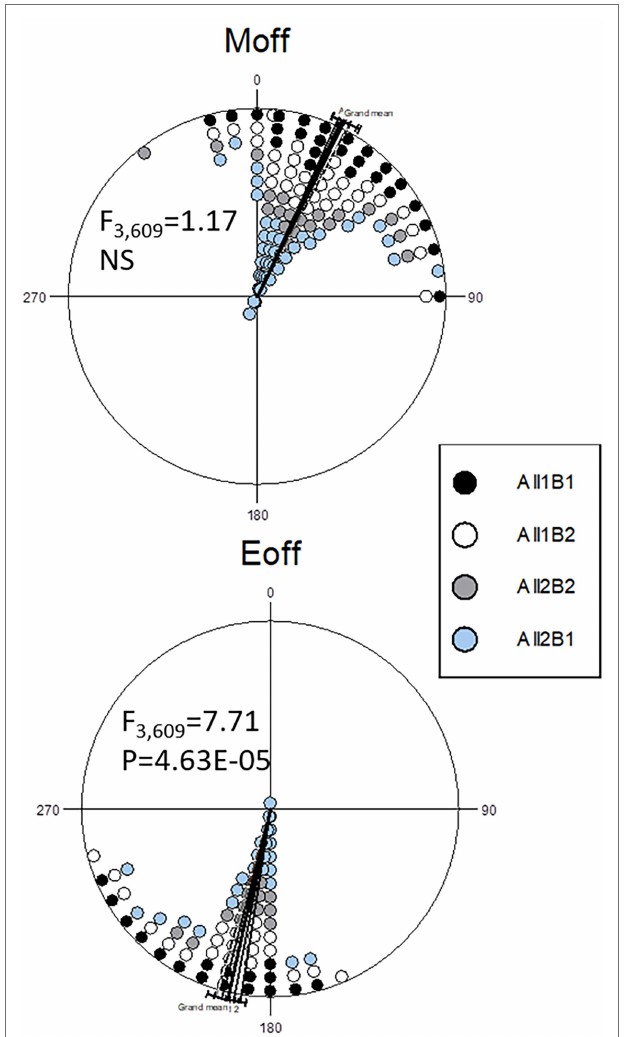
FIGURE 6 | Circadian phase under light entrainment in nearly-isogenic flies carrying different cry haplotypes. Phase distributions of the morning ( top ) and evening ( bottom ) locomotor activity bouts are shown (offset). The sector 0 ° –180 ° represents the light phase (Zt 0–12), while dark is between 181 ° and 360 ° (Zt 12–24). Each symbol represents 7–18 observations. The circular statistics Watson-Williams F -test is also shown. 15 ° = 1 h.